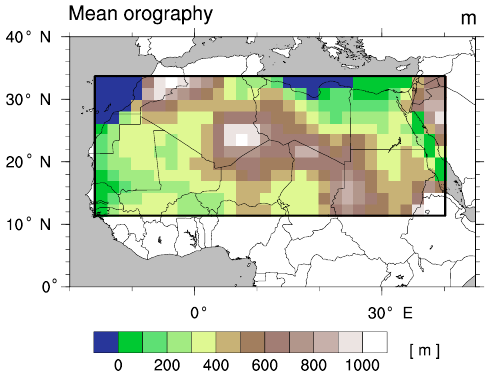
Figure 1. Mean orography (in metres) of the simulated study do- main in north Africa, 11.19 to 33.57 ◦ N, 15.94 ◦ W to 40.31 ◦ E.